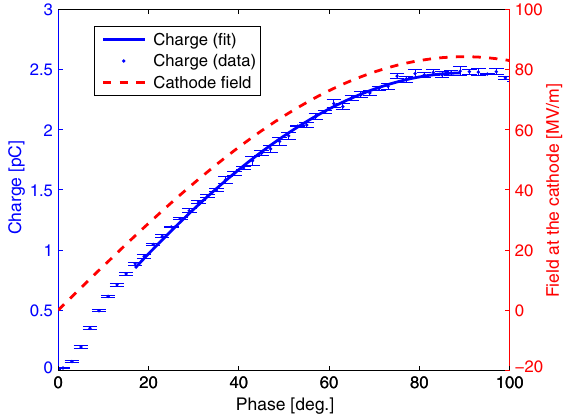
FIG. 2. Example of a Schottky scan: extracted charge (blue points) as a function of the rf phase. The effective work function ϕ is obtained by fitting the charge data according to Eqs. (2) eff and (3). The fit is indicated with the blue line. The red dashed line shows the field at the cathode for the different phases. For this example the cathode field at the extraction phase was at its nominal value ( 49 . 9 MV = m) and the rms laser beam size was around 60 μ